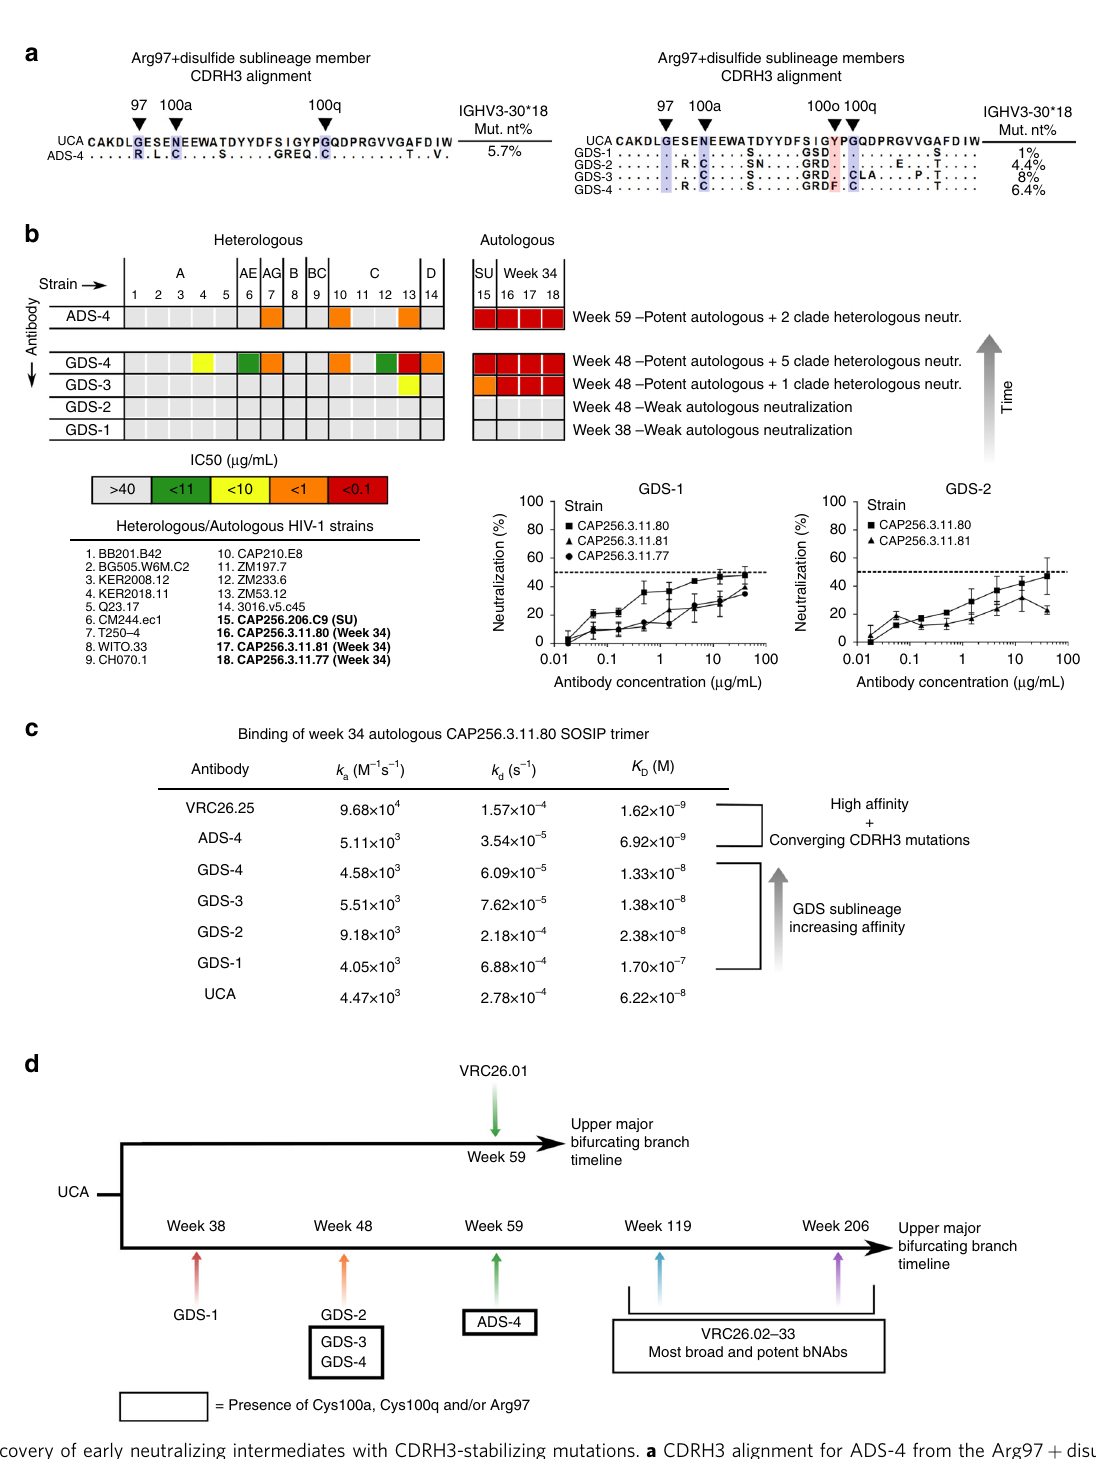
Fig. 5 Discovery of early neutralizing intermediates with CDRH3-stabilizing mutations. a CDRH3 alignment for ADS-4 from the Arg97 + disul fi de sublineage and GDS-(1 – 4) from the Gly97 + disul fi de sublineage showing the critical CDRH3-stabilizing mutations. Percent nucleotide mutation for the V H gene is shown. b Neutralization capacity for ADS-4 and GDS-(1 – 4). IC 50 values ( µ g/mL) are shown and indicate a trend in increasing potency and breadth for the Gly97 + disfulide sublineage members. Strain names in bold are autologous and the superinfecting strain (SU) and the week 34 longitudinal time point strains are labeled. Neutralization curves for GDS-1 and GDS-2 antibodies showing weak neutralization of early appearing autologous strains from week 34 are shown. c Binding kinetics of week 34 autologous strain CAP256.3.11.80 to the synthesized antibodies, the UCA and VRC26.25. d Timeline of all tested antibodies from the VRC26 lineage shown for the two major bifurcating branches. All newly identi fi ed intermediates for the early stages of the lower major bifurcating branch are in bold. Boxed sequences contain the Cys100a, Cys100q and Arg97 CDRH3 mutations. Only the lower major bifurcating branch leads to the most potent and broad antibodies with stabilizing mutations. Note that VRC26.24, while isolated at week 193, is actually phylogenetically placed on the upper branch by exon analysis and lacks the three stabilizing mutations